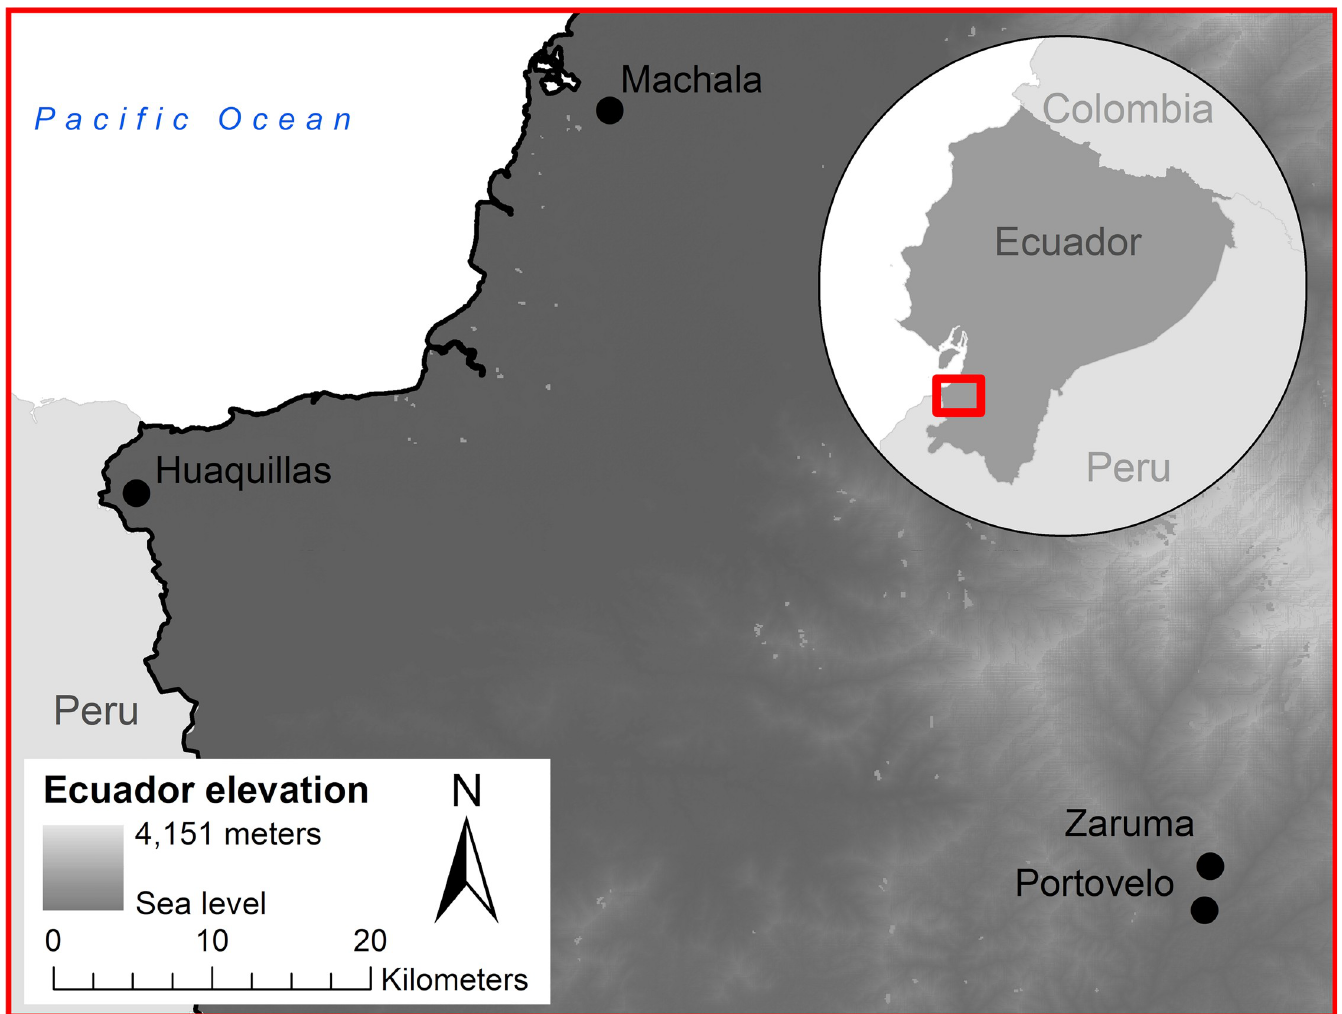
Fig 1. Map of the four study site cities: Machala, Huaquillas, Portovelo, and Zaruma, in southern Ecuador.